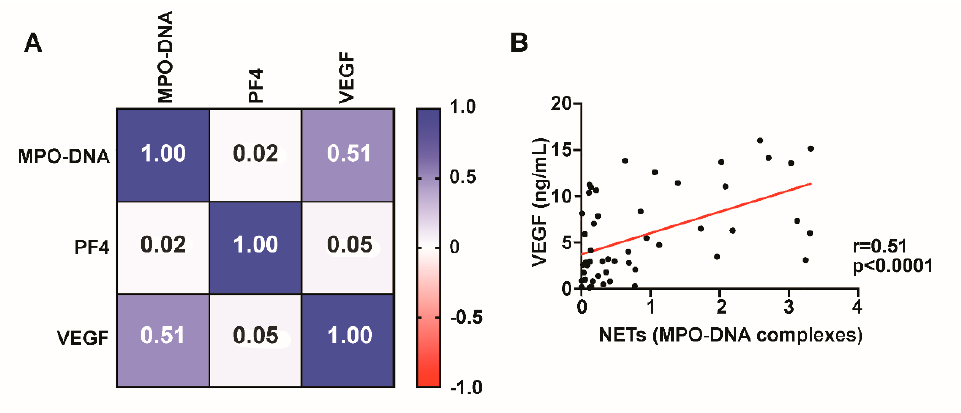
Figure 3. NET formation correlates with VEGF levels. Spearman’s rank correlation coefficient matrix of NET levels compared with PF4 and VEGF using day 1 CDSH fluid ( A ). MPO-DNA complexes significantly ( p < 0.0001) correlate with VEGF levels in fluid from NASH (( B ), p < 0.0001).